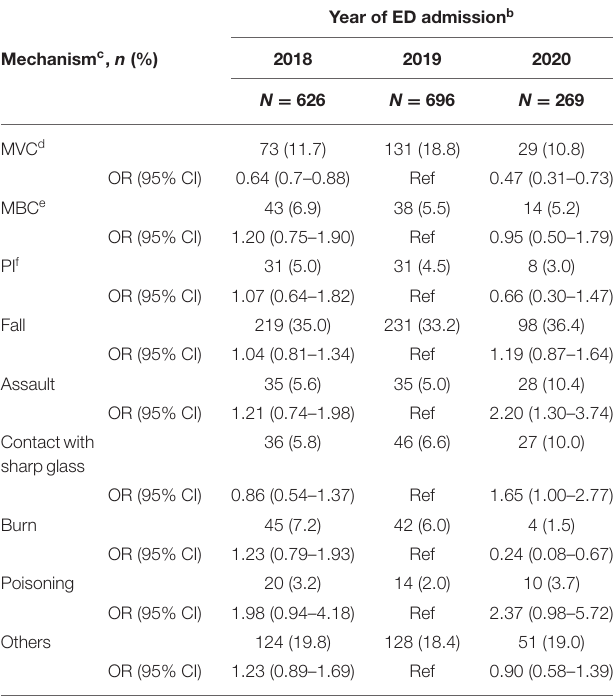
TABLE 2 | The association of the lockdown period of 2020 and the similar periods of 2018 and 2019 with several mechanisms of injury presented as odd ratios (OR) and 95% confidence interval (CI) a